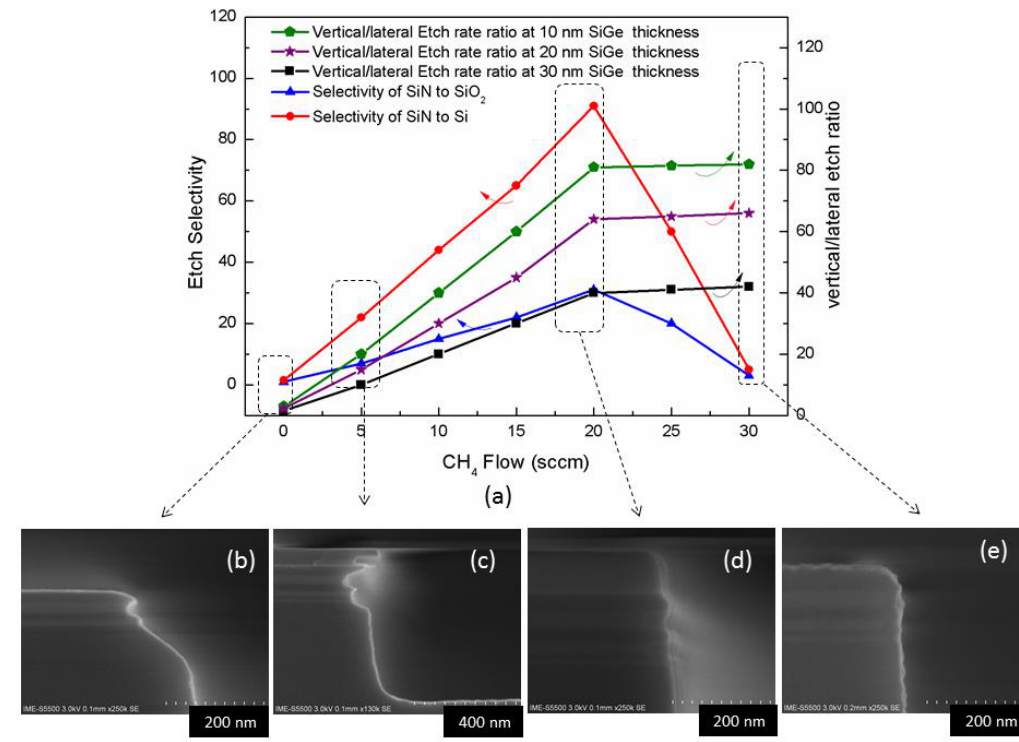
Figure 5. Impact of CH 4 flow on etching: ( a ) the dependence of etch selectivity and vertical / lateral etch ratio on CH 4 flow; ( b ) etching profile without CH 4 ; ( c ) etching profile of 5 sccm CH 4 flow; ( d ) etching profile of 20 sccm CH 4 flow; ( e ) etching profile of 30 sccm CH 4 flow;